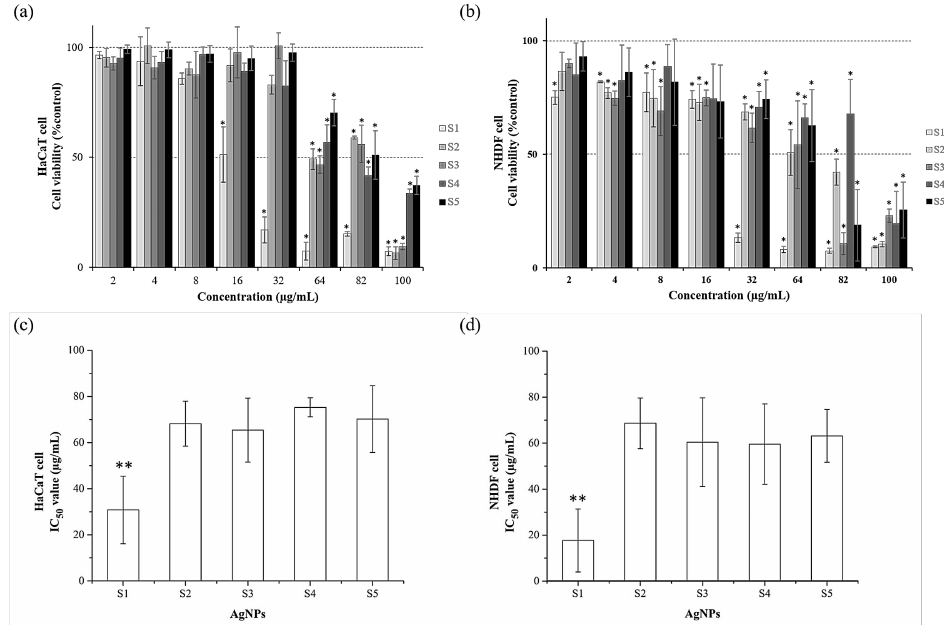
Figure 3. Cytotoxicity of AgNPs evaluated by MTT assay. Cell viability of HaCaT and NHDF cells ( a , b ) and IC 50 of AgNPs in HaCaT and NHDF cells ( c , d ). The cells were incubated with five types of AgNPs (S1–S5) at 2–100 µ g/mL for 24 h. The cell without AgNPs was the control with 100% viability. Data represent mean value ± SD (error bar) from two independent experiments carried out in triplicate ( n = 6). An asterisk (*) indicates significant differences in comparison to the control without AgNPs ( p < 0.05). ** Asterisks denote a significantly different p -value ( p < 0.05) comparing AgNSs with other